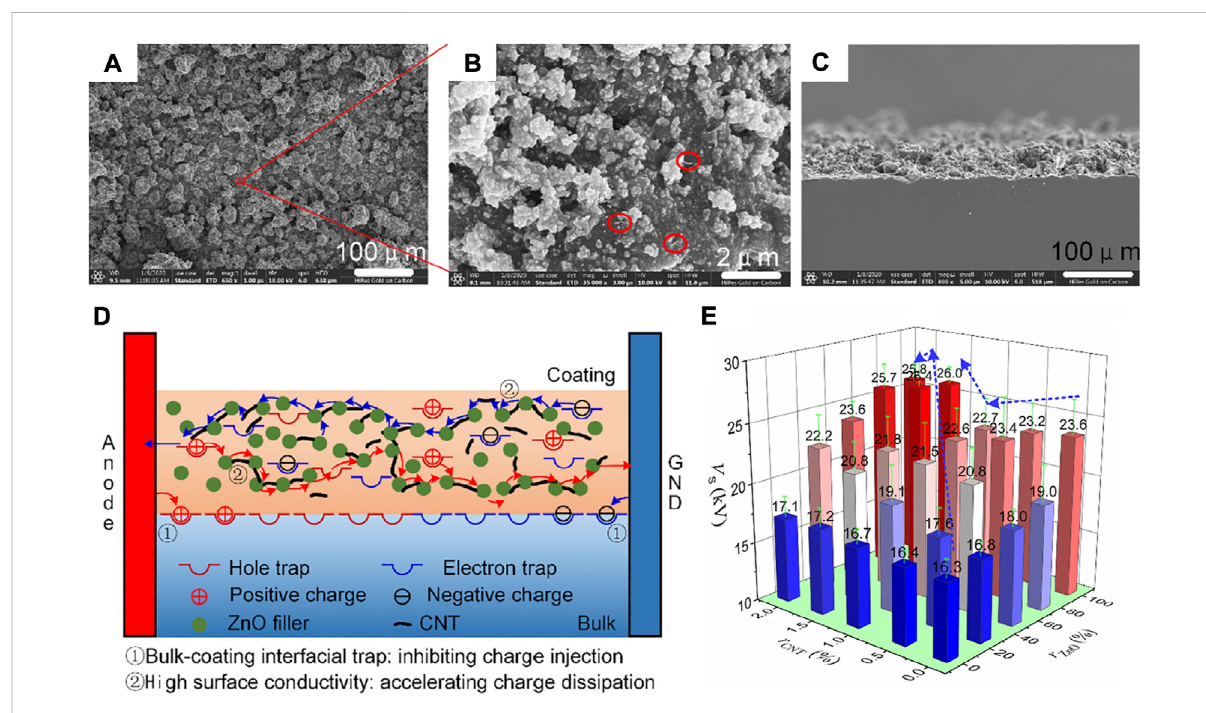
FIGURE 6 SEM images of the prepared ZnO/MWCNT/PDMS coating with (A) ×650 and (B) ×35000 magni fi cation, The red circle is MWCNT (Zhu et al., 2021). (C) Cross-sectional SEM image of the coated sample (Zhu et al., 2021). (D) Schematic diagram describing the effect of deep interfacial traps and enhanced surface conductivity on surface charge accumulation (Zhu et al., 2021). (E) The fl ashover voltages of coating fi lm with systematically varied concentrations of ZnO and MWCNT fi llers (Zhu et al.,